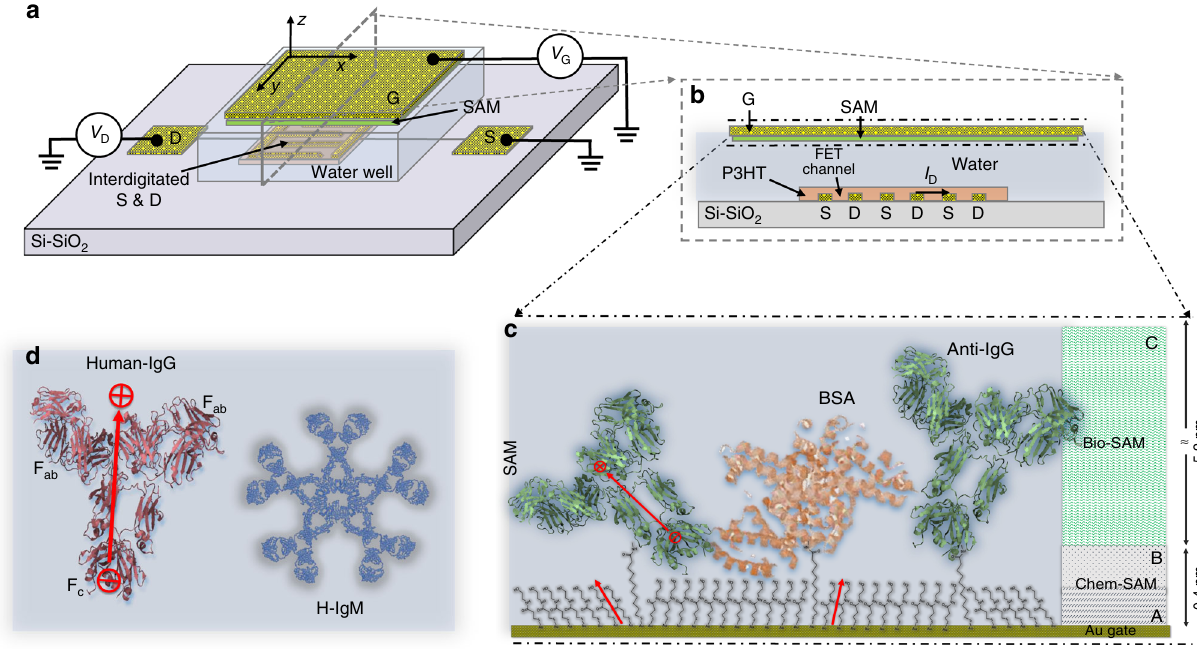
Fig. 1 The SiMoT electrolyte-gated OFET. a The three-dimensional schematic structure of the FET. b The cross-sectional structure of the transistor channel region. The source (S) and drain (d) interdigitated contacts are de fi ned on a Si/SiO 2 substrate and covered by a spin coated p-type, Poly(3-hexylthiophene- 2,5-diyl)-P3HT, organic semiconductor (OSC) layer. A 300 μ l volume of HPLC-grade water is dispensed into a polydimethylsiloxane well covering the OSC surface. A bio-functionalized Au-gate stably hangs over the device at a distance of ~4 mm from the OSC surface while in contact with the water. The capturing SAM, comprising both a chem-SAM of activated-and-blocked 3-mercaptopropionic acid (3-MPA) and 11-mercaptoundecanoic acid (11-MUA) and a bio-SAM of capturing proteins, is sketched in ( c ). For the sake of clarity, features are not in scale. The dipole moments associated with the different components are schematically depicted with red arrows. The whole SAM thickness is 5.6 nm (Supplementary Note 2) and a surface characterization of the SAM is reported in Supplementary Note 3. The structure of IgG and IgM ligands are depicted in ( d